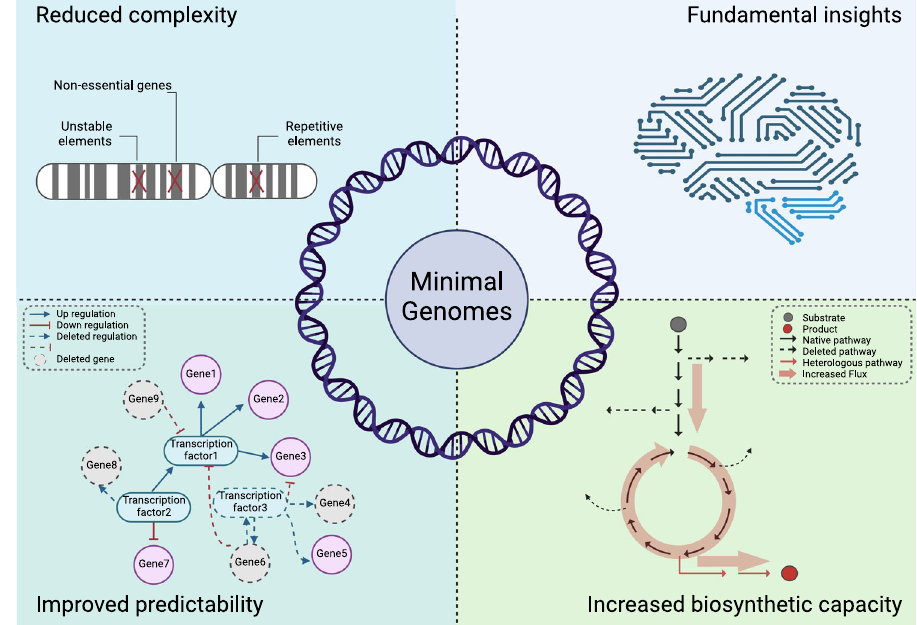
Fig. 1 | Applications of synthetic and synthetic-minimal genomes. Synthetic genomes provide opportunities to better engineer and understand biology by: reducing the genome complexity by removing non-essential genes and improving genome stability by removing repetitive elements; increasing the predictability of